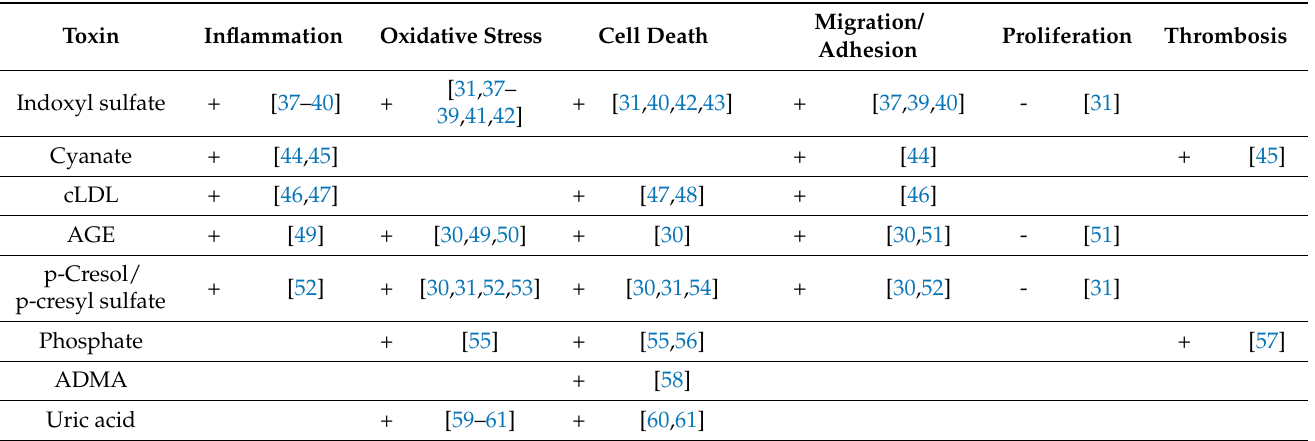
Table 1. Effects of uremic toxins on key mechanisms in endothelial